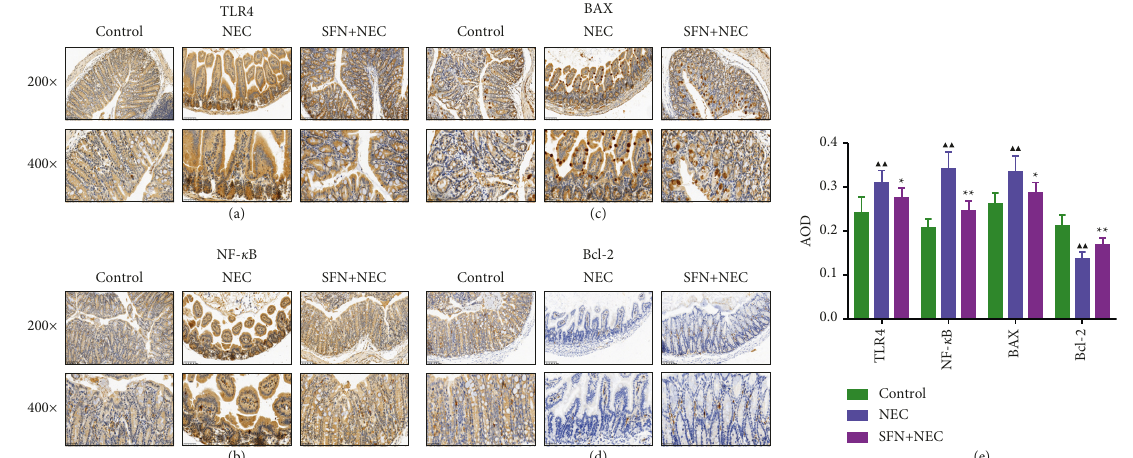
Figure 4: Immunohistochemical staining of TLR4 (a), NF- κ B (b), Bax (c), and Bcl-2 (d) and semiquantitative analysis of these proteins expression (e) in intestinal tissues of mice. NEC, necrotizing enterocolitis; SFN, sulforaphane. Compared with the control group, ▲ P < 0 . 05, ▲▲ P < 0 . 01; compared with the NEC group, ★ P < 0 . 05, ★★ P < 0 . 01. Data represent the mean ± SD, n � 6.